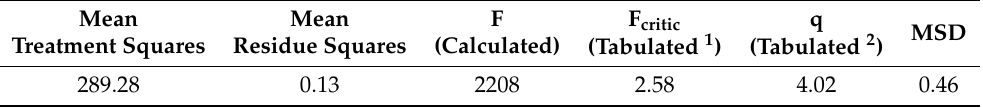
Table 9. ANOVA and Tukey’s test parameters for the Young’s